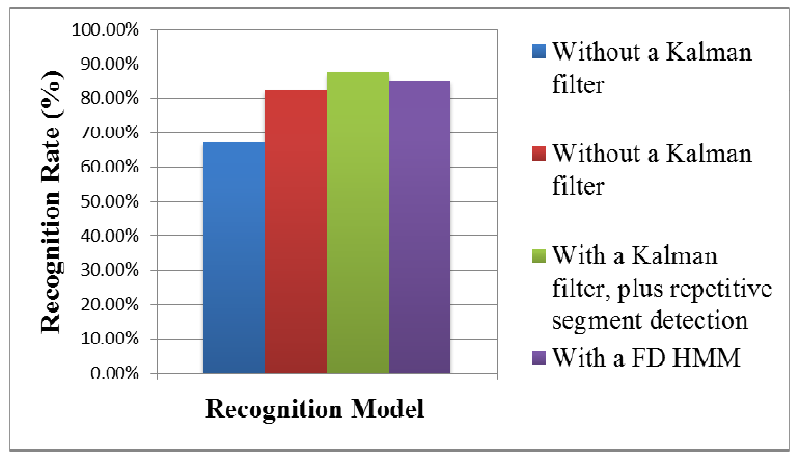
Figure 26. The recognition results of dynamic hand